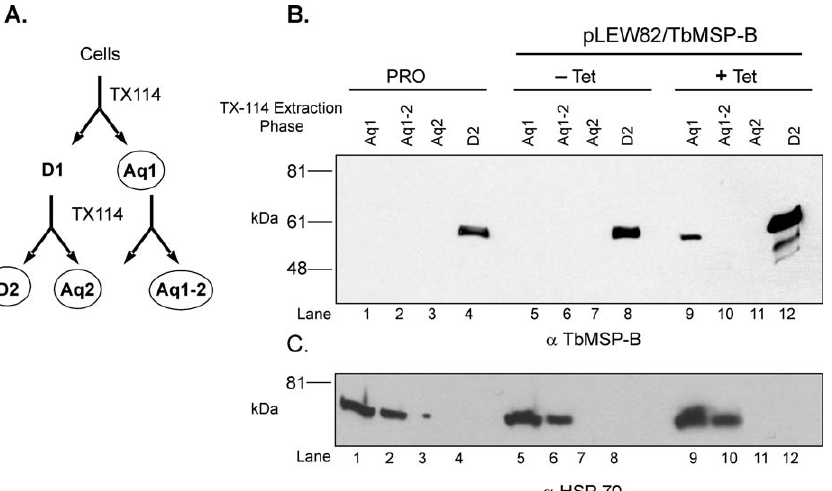
Figure 1. TbMSP-B Is an Integral Membrane Protein (A) Summary of the TX-114 extraction protocol used to separate trypanosome cytosolic proteins (Aq phases) and integral membrane proteins (D phases). Circled fractions were used in the western blots shown in the other panels. (B and C) PRO cells (lanes 1–4) and PRO cells containing integrated pLEW82/TbMSP-B, either not induced (lanes 5–8) or induced (lanes 9–12) with 1 l g tetracycline/ml, were subjected to TX-114 extraction and analyzed by western blots probed with antisera directed against (B) TbMSP-B ( a TbMSP-B) and (C) HSP-70 ( a HSP-70) as a control to detect a cytosolic protein and confirm purity of extraction phases.